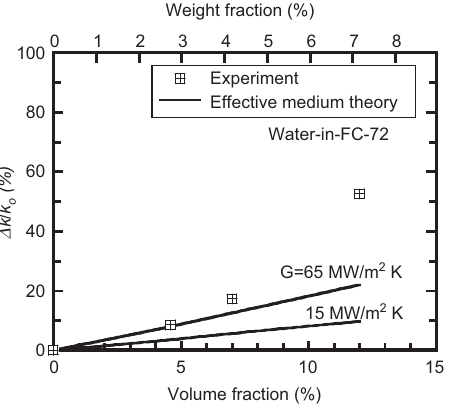
Figure 10 The relative thermal conductivity of the FC-72 nanoemul- sion fluids vs. the water volume concentration. The effective thermal conductivity estimated from the effective medium theory for the spherical particles is shown for comparison.